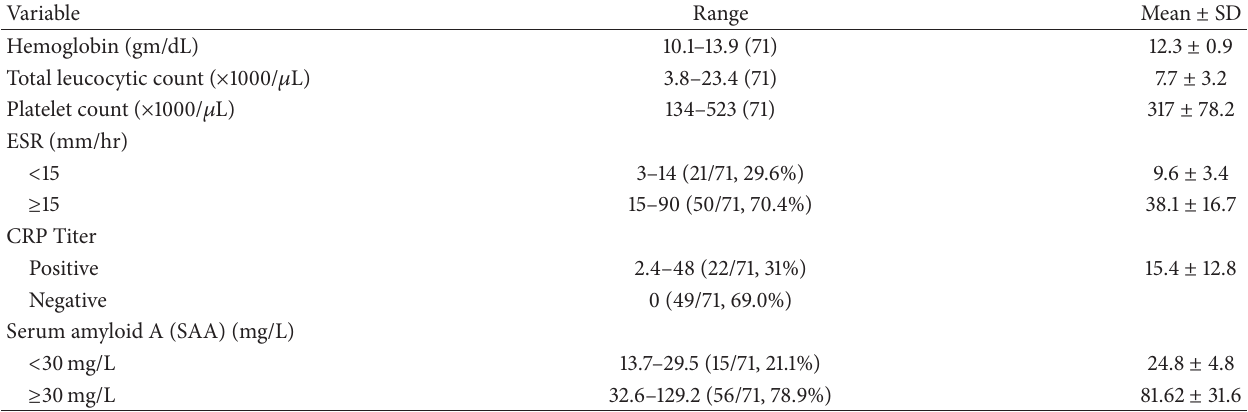
Table 2: Laboratory findings of studied FMF patients at the time of